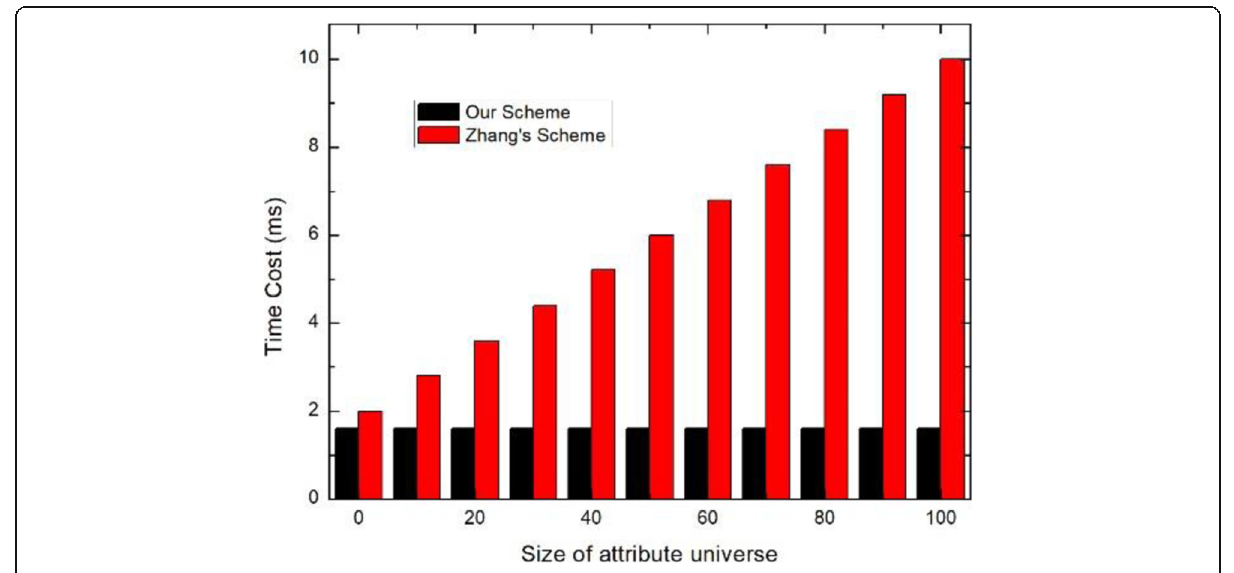
Fig. 8 Decryption Time of DU with Different Size of Attribute Universe